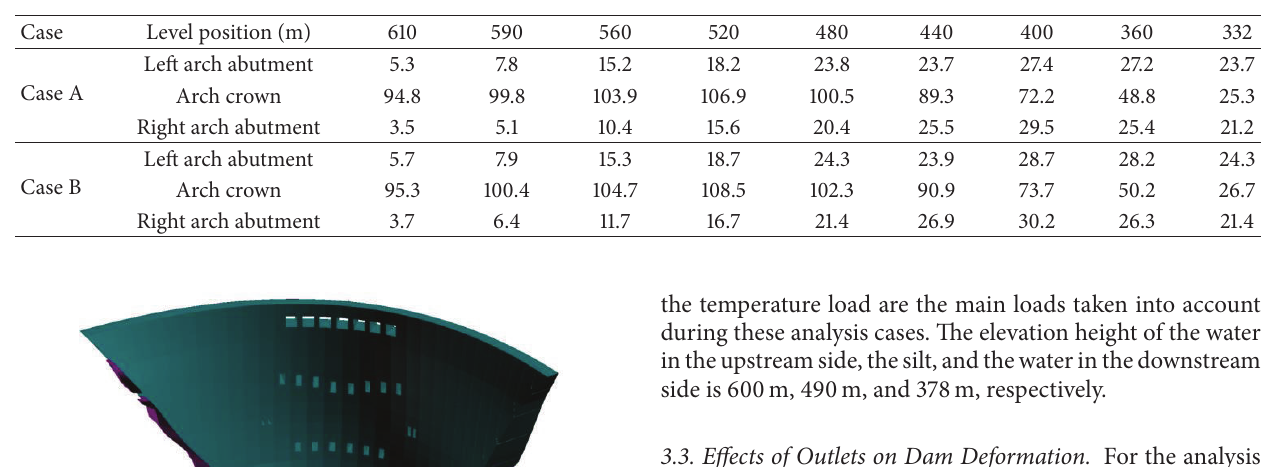
Table 4: Dam displacement at the downstream side along the river direction under various analysis cases (unit: mm).